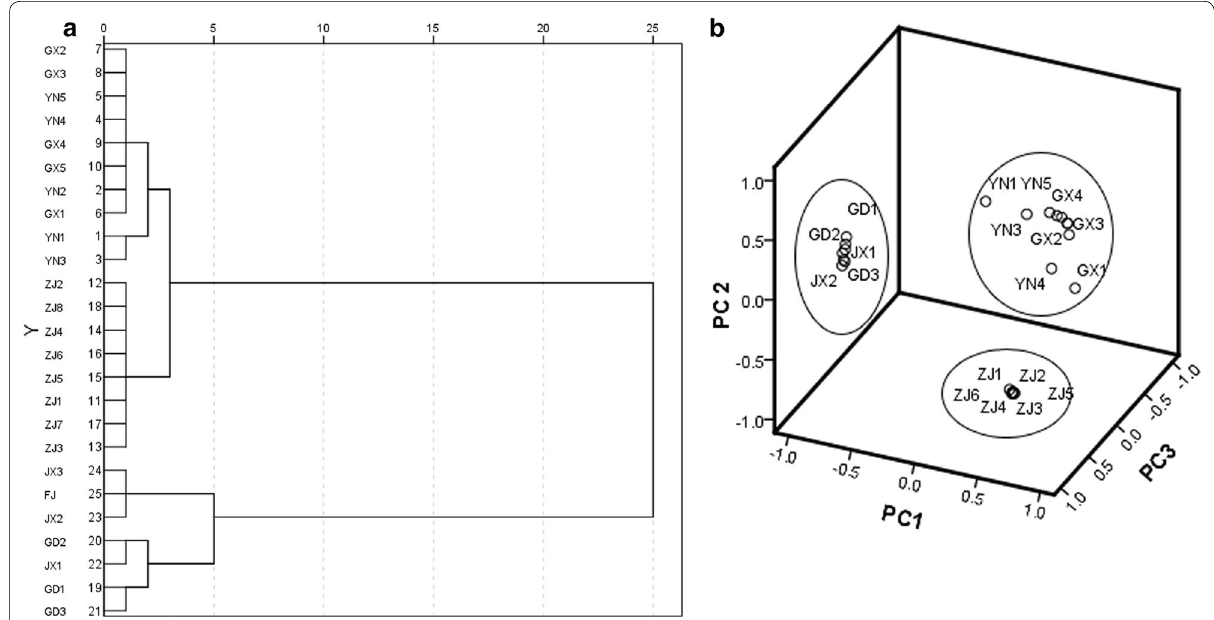
Fig. 5 Dendrogram of hierarchical cluster analysis (HCA) for 25 samples of Dendrobium officinale ( a ), Principal component analysis (PCA) for 25 samples of Dendrobium officinale ( b